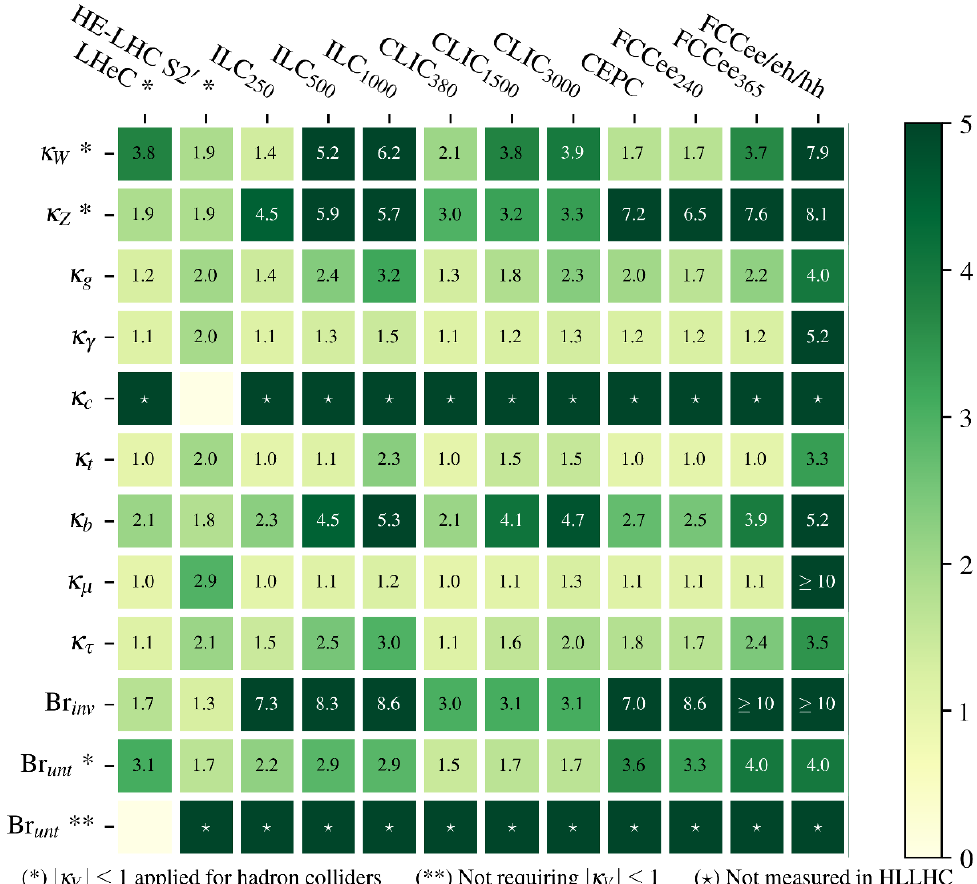
Figure 19 . Graphic comparison of the improvement with respect to HL-LHC in the Kappa-3 framework.